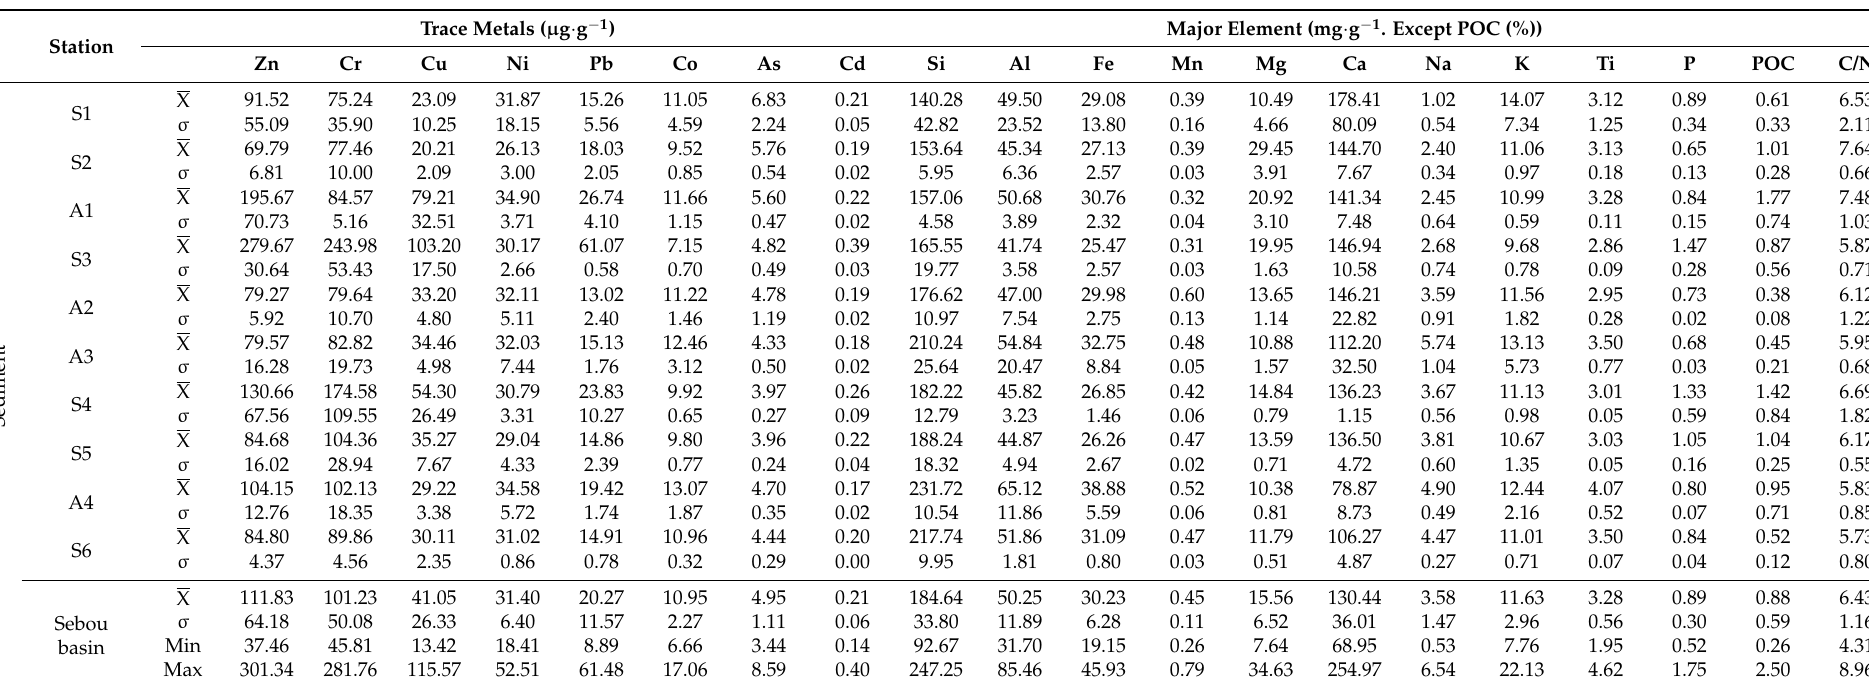
Table 1. Mean (X), standard deviation ( σ ), minimum (min), and maximum (max) concentrations of major, trace metals, POC, and C/N ratio in sediments collected during the sampling periods (n = 36), at each sampling site of the Sebou River and its tributaries. The mean (X) concentration of TM in the sediments of two carbonate basins (the Tafna Basin (Algeria, [16]) and the Upper Pearl River basin (China, [55])) are shown, as well as the mean (X) concentration of TM in the sediments of three regional basins in Morocco (Bouregreg river, Bouregreg watershed, [56]; Day River, Oum Rabia Watershed, [57]; Ansguemir River, Moulouya Watershed, [58]). The mean total concentration of the Sebou bedrock (this study, Table S3), of the Tafna bedrock [16], and of the UCC composition [47], are presented. Values of TEL (Threshold Effect Level) and PEL (Probable Effect Level) of sediment quality guidelines are mentioned [53].